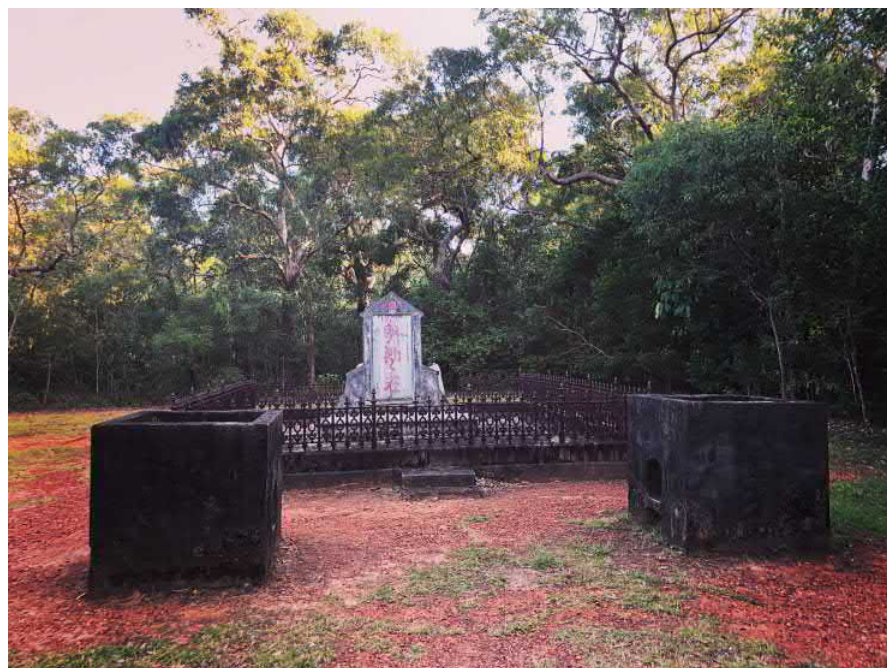
Figure 9: Chinese Shrine, Cooktown Cemetery. (Photo: Anna